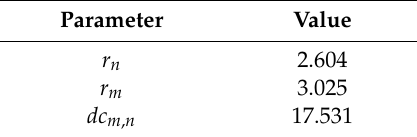
Figure 4. The relationship between different percentages of samples for training and classification accuracy, with / without feature selection (Fisher score). Table 2. Cluster